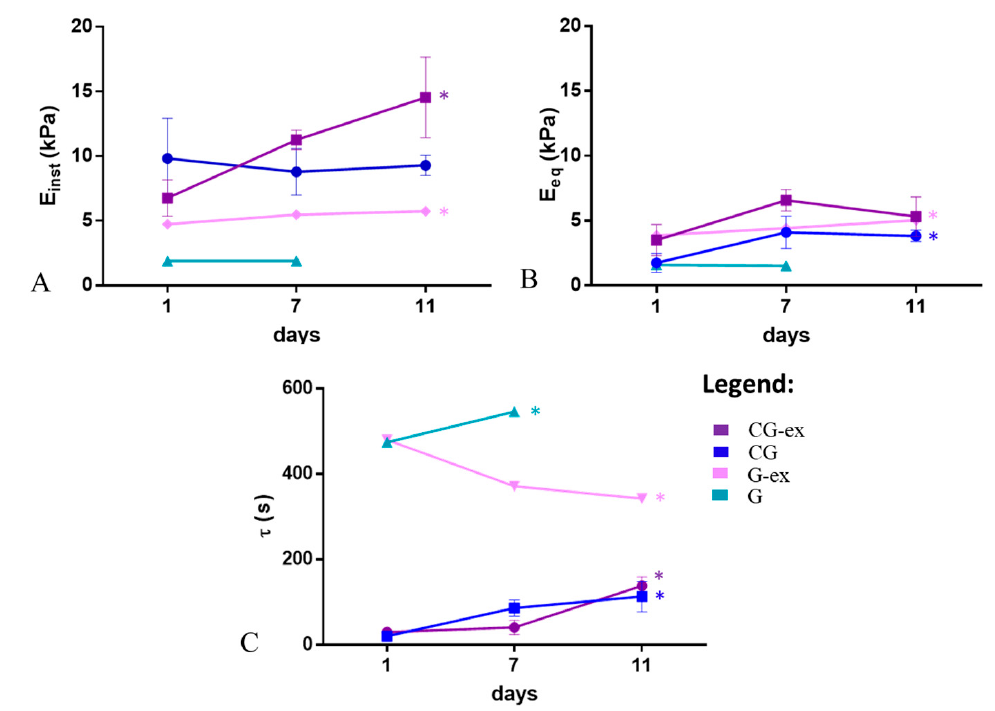
Figure 6. Viscoelastic descriptors over time measured in the bioreactor: ( A ) instantaneous, E inst = E 0 and ( B ) equilibrium modulus, ( E eq = E 0 E 1